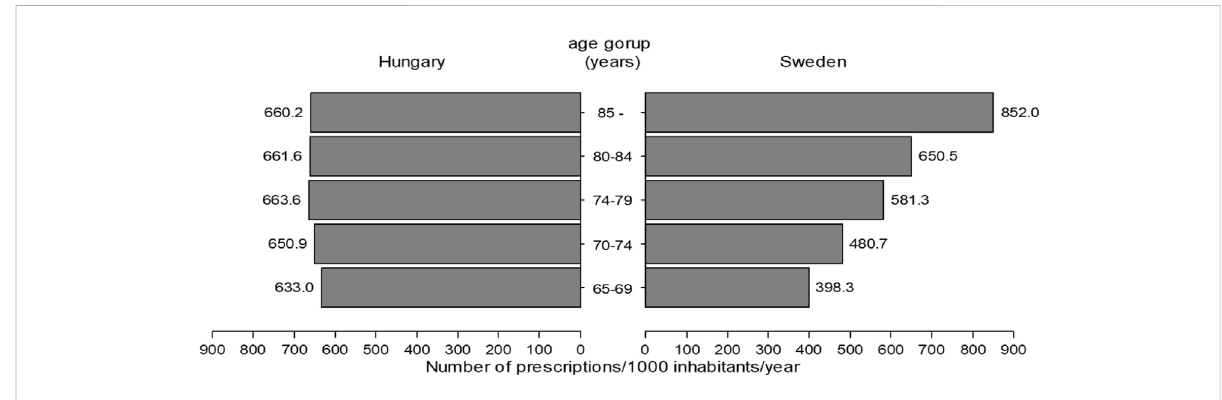
FIGURE 1 Antibacterial use in different elderly age subgroups in Hungary and Sweden